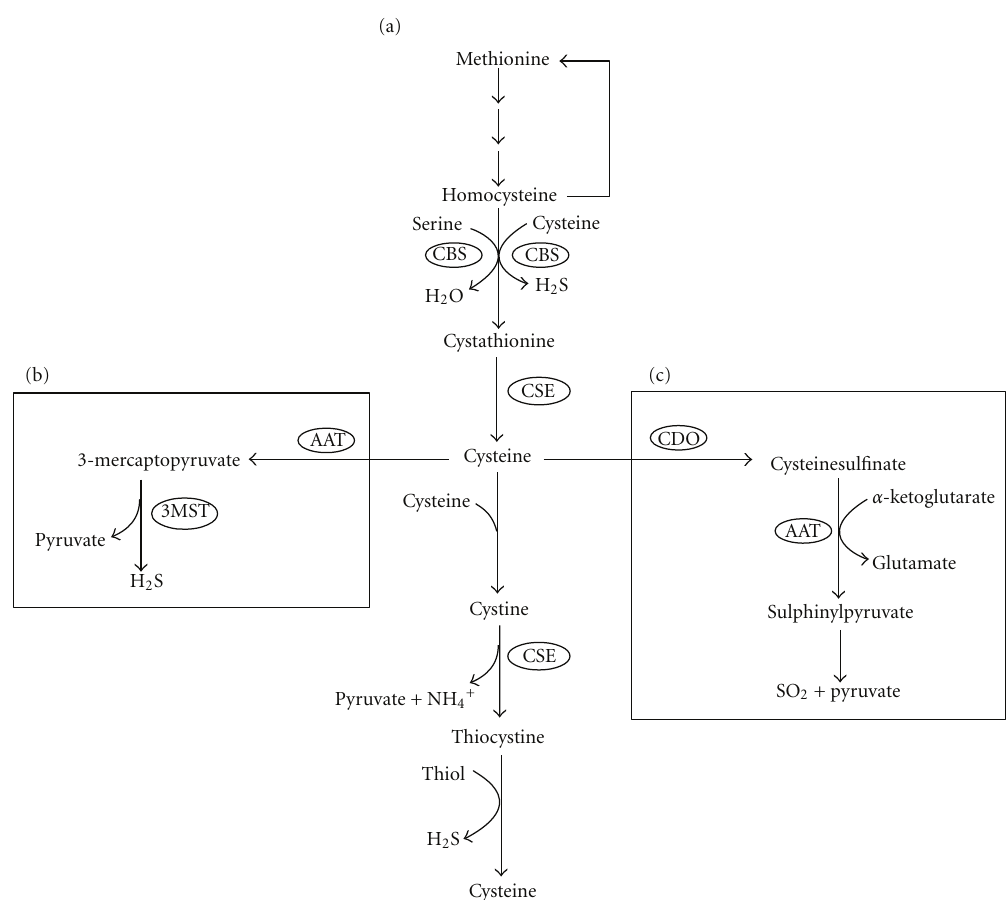
Figure 1: Metabolism of sulfur containing amino acids. (a) Homocysteine-dependent transsulfuration pathway that containing both cystathionine- β -synthase (CBS) and cystathionine- γ -lyase (CSE). Which is located in the cytosol and generates hydrogen sulfide (H 2 S). (b) H 2 S synthesis via aspartate aminotransferase (AAT) and 3-mercaptopyruvate sulfurtransferase (3MST), which occurs in the cytosol